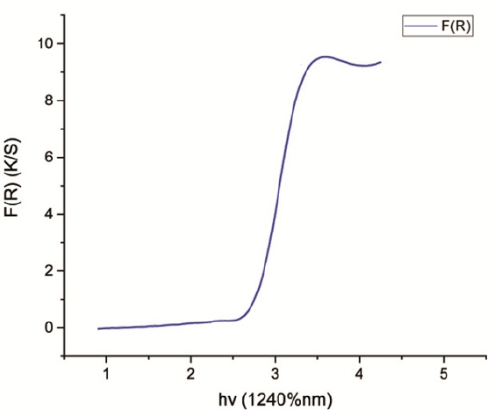
Figure 2. DRS pattern, showing energy band gap of TiO 2 nanoparticles synthesized by Bacillus subtilis .